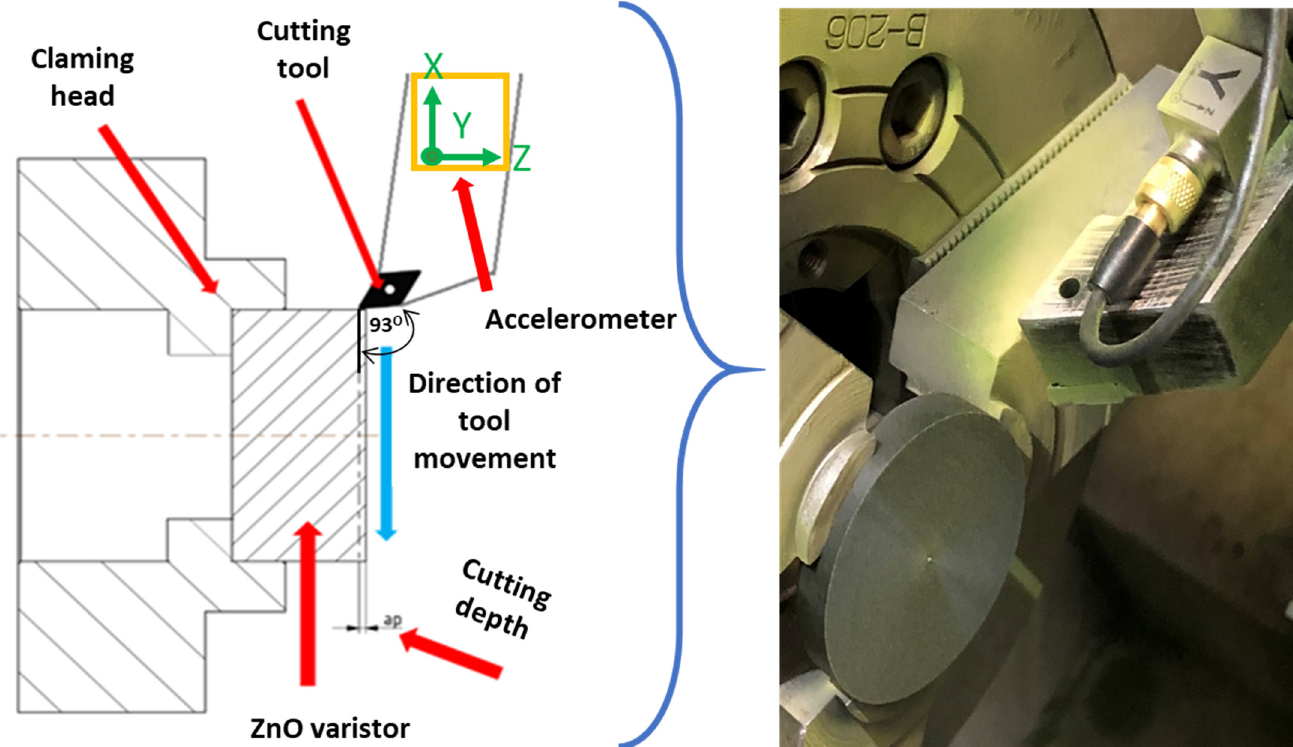
Figure 3. Schematics of the turning operation on a ZnO varistor.